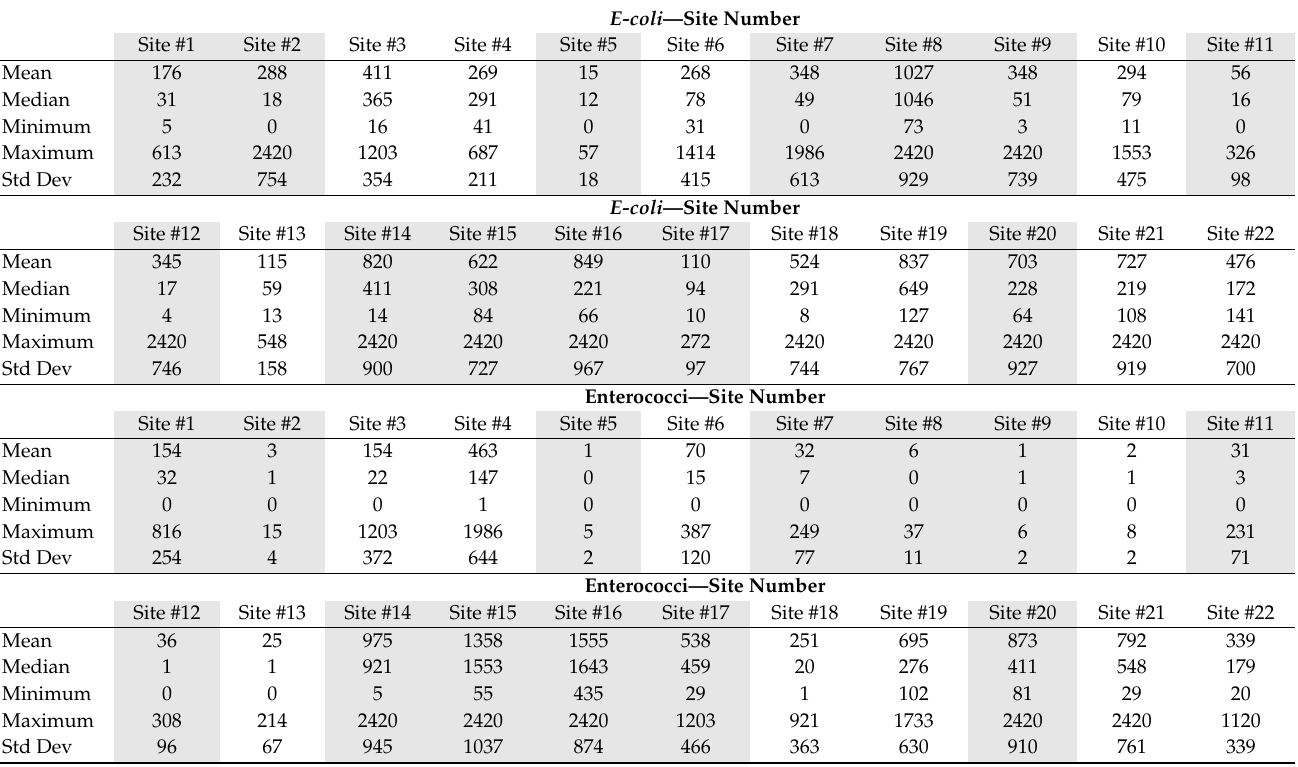
Table A1. Descriptive statistics of E. coli and enterococci concentrations (CFU per 100 mL) at each sampling location ( n = 22) during the current study period (3 March–3 November 2020) in West Run Watershed, WV, USA. Shaded columns identify tributaries to main stem West Run Creek (unshaded). E-coli —Site Number